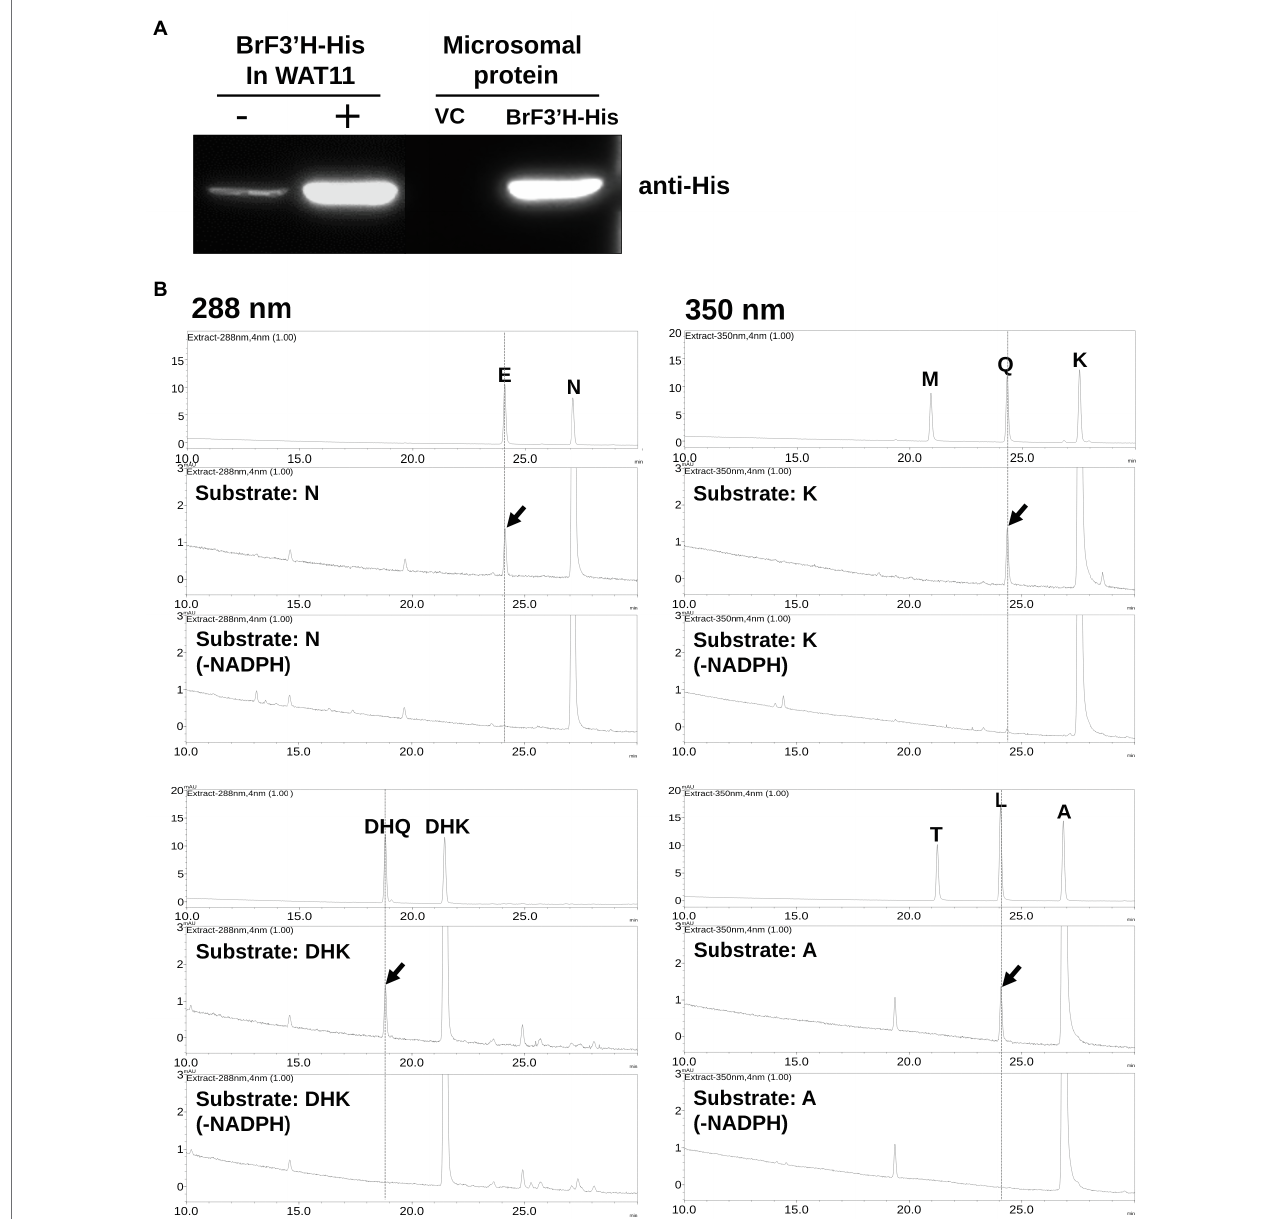
FIGURE 6 | In vitro assay for recombinant Br F3 ′ H-8267 protein. (A) Immunoblot analysis to verify the expression of recombinant His-tagged Br F3 ′ H-8267 protein ( Br F3 ′ H-His) in yeast cells (left) and microsomal fraction (right). Br F3 ′ H-His was detected using an anti-His antibody. – and +, non-induced and induced by IPTG; VC, vector control. (B) The in vitro reactions using recombinant Br F3 ′ H protein were conducted along with the reactions without NADPH (-NADPH) as negative control, which were then analyzed using HPLC. Peaks were detected at 288 nm for dihydroflavonols (DHQ and DHK) and flavanones (E, eriodictyol; N, naringenin) and at 350 nm for flavonols (M, myricetin; Q, quercetin; K, kaempferol) and flavones (T, tricetin; L, luteolin; A, apigenin). The peaks were identified by comparing relative retention times and UV spectra to the standards, and peaks corresponding to 3 ′ -hydroxylated flavonoids produced by recombinant Br F3 ′ H-8267 are represented by red